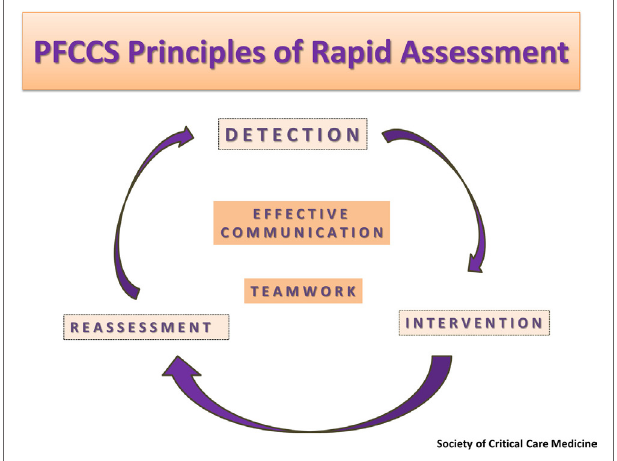
Figure 1 | Timeline for instructor training with specific goals for each